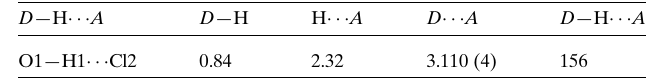
Table 1 Hydrogen-bond geometry (A˚ , (cid:4) ).